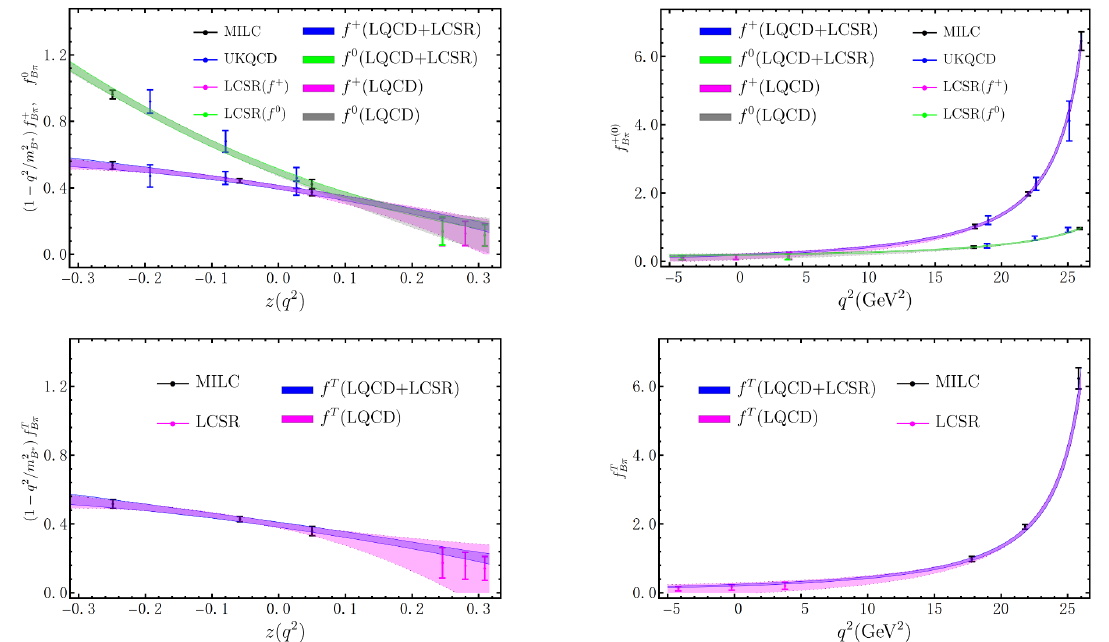
Figure 7 . Theory predictions for the complete set of the semileptonic B → π form factors versus z (left panel) and versus q 2 (right panel) in the entire kinematic region obtained by carrying out the combined BCL z -fit of the updated LCSR (from this work) and lattice QCD (from [3, 4, 7]) data points. We further display the yielding numerical results of these form factors by performing an alternative z -series fit against the “ only lattice QCD ” data points [3, 4, 7] exclusively for a